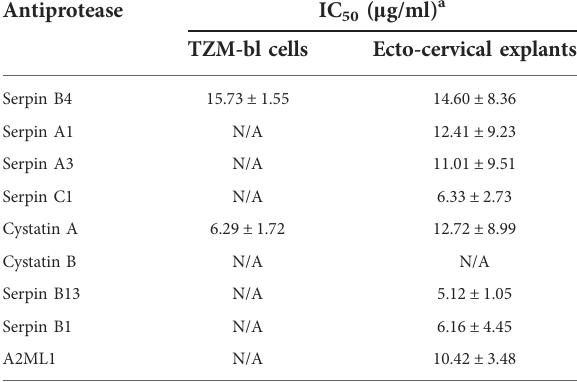
TABLE 1 IC 50 of antiproteases against HIV-1 BaL in different models. Antiprotease